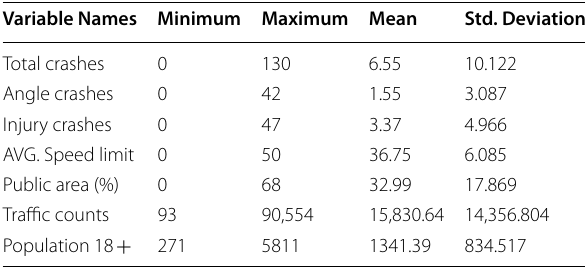
Table 2 Descriptive statistics of the main variables Variable Names Minimum Maximum Mean Std.